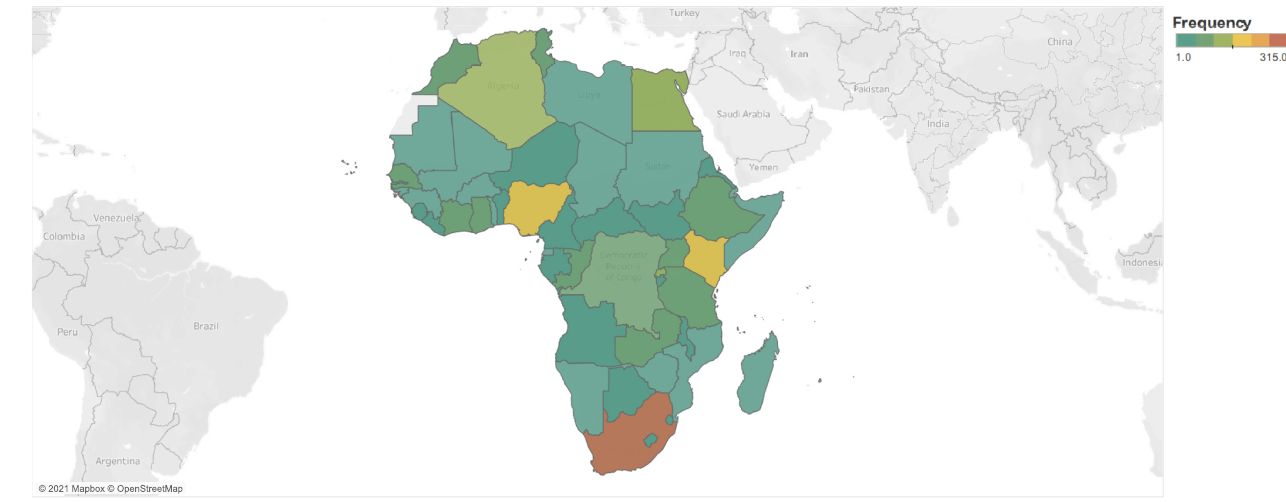
Fig 2. Respondents’ knowledge of neurosurgical care availability in Africa.